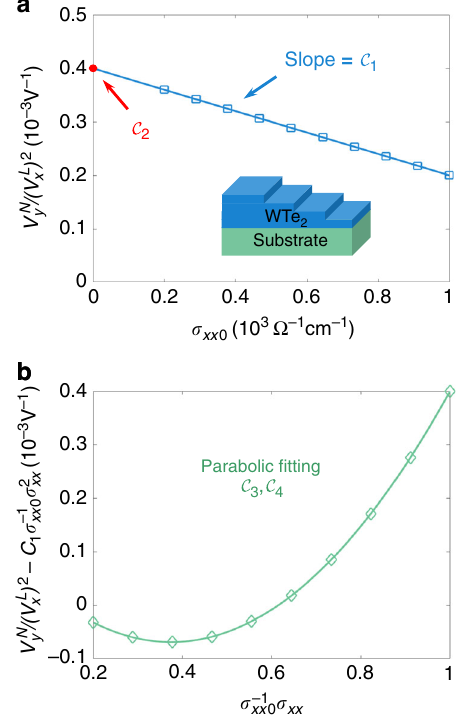
Fig. 3 Scaling law of the nonlinear Hall effect. a Step 1. At zero temperature, 2 and σ fi tting C = ð V L N xx 0 for samples of different 1 and C 2 with the data of V y x Þ disorder strength (e.g., by changing the thickness 20,21 ). Insert is the schematic of the WTe 2 multi-step sample. b Step 2. At fi nite temperatures, for a given sample of known σ xx 0 , fi tting C 3 and C 4 with the data of σ xx at different temperatures. C 1 ; 2 ; 3 ; 4 can give most coef fi cients of physical ( a ) and meanings in Eq. (7) ll ′ of the 2D tilted massive yxx